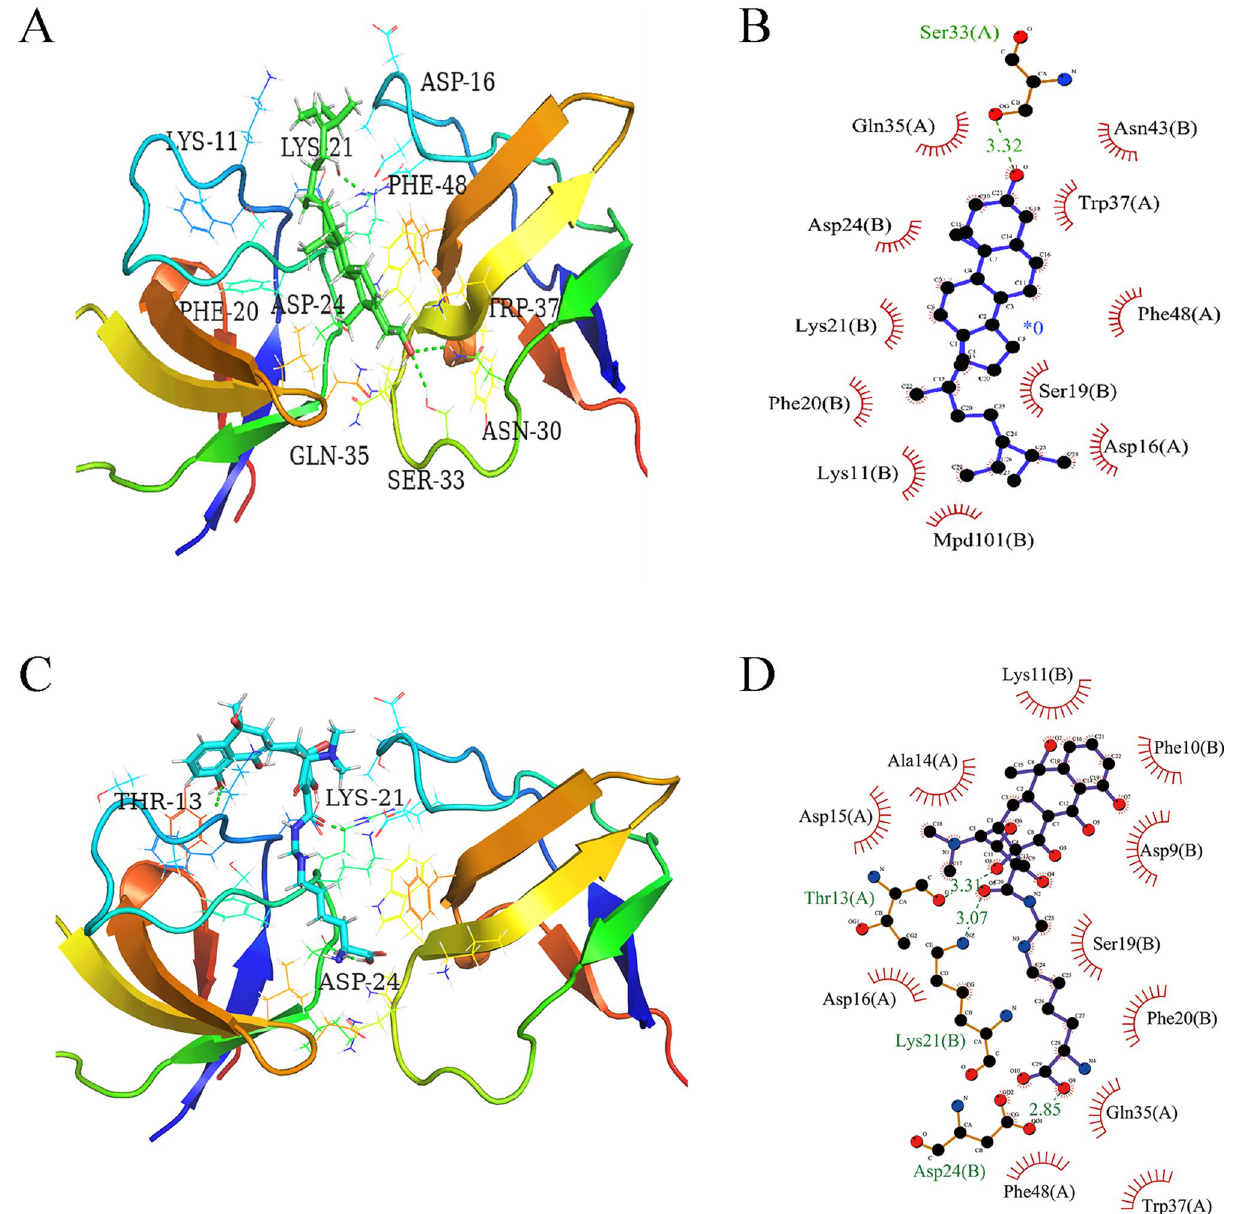
Figure 9. Fucosterol and Lymecycline showing molecular interactions with GRB2 and 2D representation of H-bonds and hydrophobic interactions of fucosterol and Lymecycline with GRB2. ( A , B ) Fucosterol and GRB2. ( C,D ) Lymecycline and GRB2. The green stick is shown as fucosterol, the blue stick is shown as lymecycline, the hydrogen bond is shown as the green dotted line. Ligand is colored and represented in purple color, hydrogen bonda is displayed in green dotted lines, red stellations represent hydrophobic interactions, and bonds of proteins are shown in brown color. Figure ( A & C ) were created from Pymol2.4 (https ://pymol .org), ( B & D ) were made in Ligplot2.3 (http://www.csb.yale.edu/userg uides /graph ics/ligpl ot/manua l/index